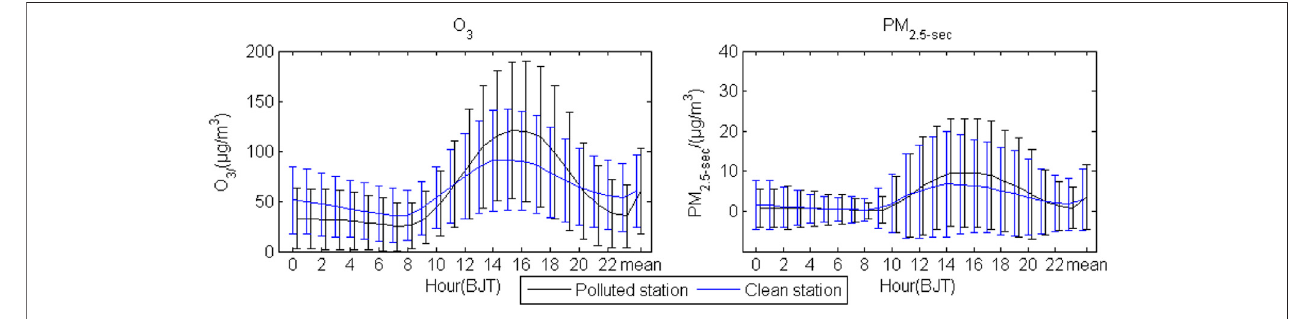
FIGURE 11 | Diurnal variations of ozone and PM 2.5-sec under different photochemical